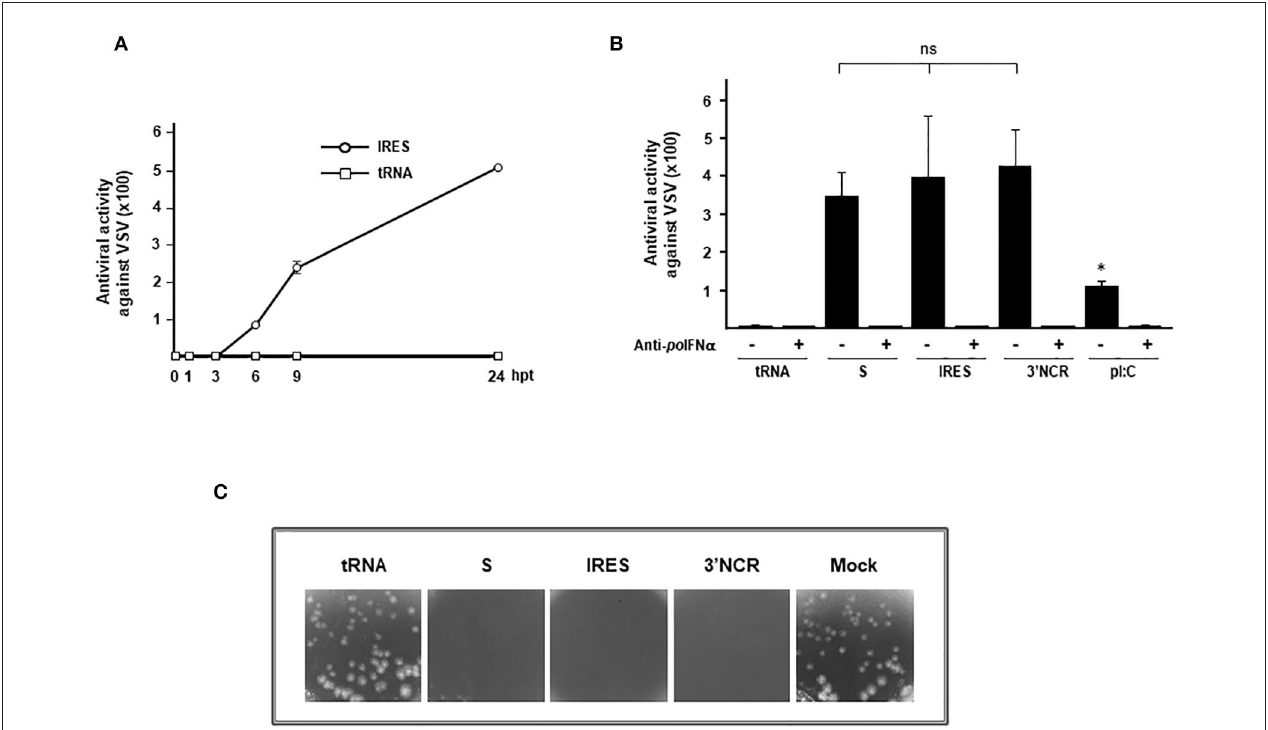
FIGURE 2 | Antiviral activity against VSV induced in WSL cells by transfection with the ncRNAs. (A) Antiviral activity of supernatants from IRES-transfected WSL cells, collected at different times after transfection and corresponding to lysates analyzed in Figures 1B,C . Supernatants from WSL cells transfected with tRNA were also analyzed as a control. The antiviral activity was assayed on fresh WSL monolayers against VSV infection. Data are average of triplicates ± SD. (B) The antiviral activity in supernatants from WSL cells transfected with S, IRES, 3 ′ NCR transcripts, pI:C or tRNA for 24h was assayed on fresh WSL monolayers against VSV. Where indicated, supernatants were incubated previously with antibodies against swine IFN- α . Data are average of triplicates from two independent experiments ± SD (* p < 0.05; ns, not significant). Antiviral activity was expressed as the reciprocal of the highest supernatant dilution needed to reduce the number of VSV plaques by 50%. (C) Autocrine antiviral activity in WSL cells transfected with the ncRNAs. WSL cells were transfected with each ncRNA, tRNA or mock-transfected and 24h later infected with VSV. A comparison of the CPE induced after 24h of infection is